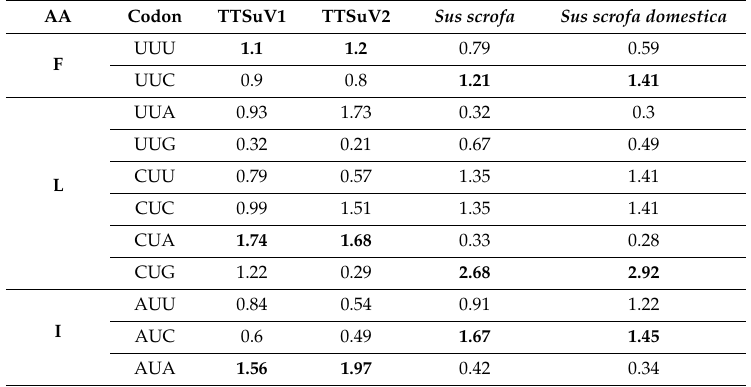
Table 1. RSCU values of TTSuV1 and TTSuVk2 and of the hosts, Sus scrofa and Sus scrofa domestica